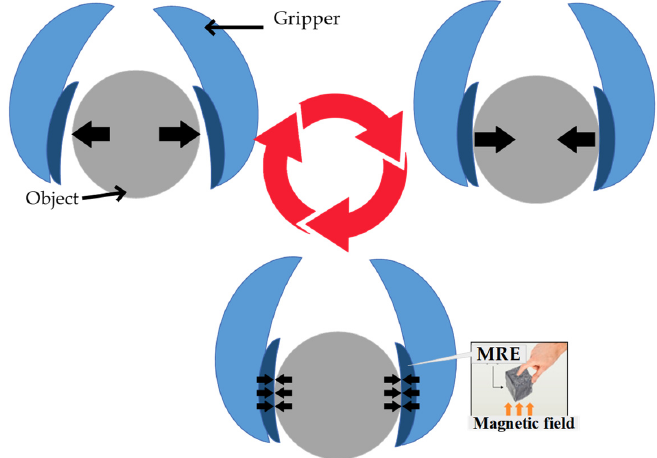
Figure 7. The cycle of use of soft robotic gripper with MREs.